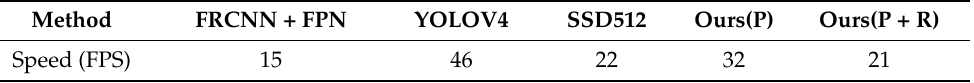
Table 5. Running speed Comparison of 640 × 480 images (P is short for proposal, R is short for